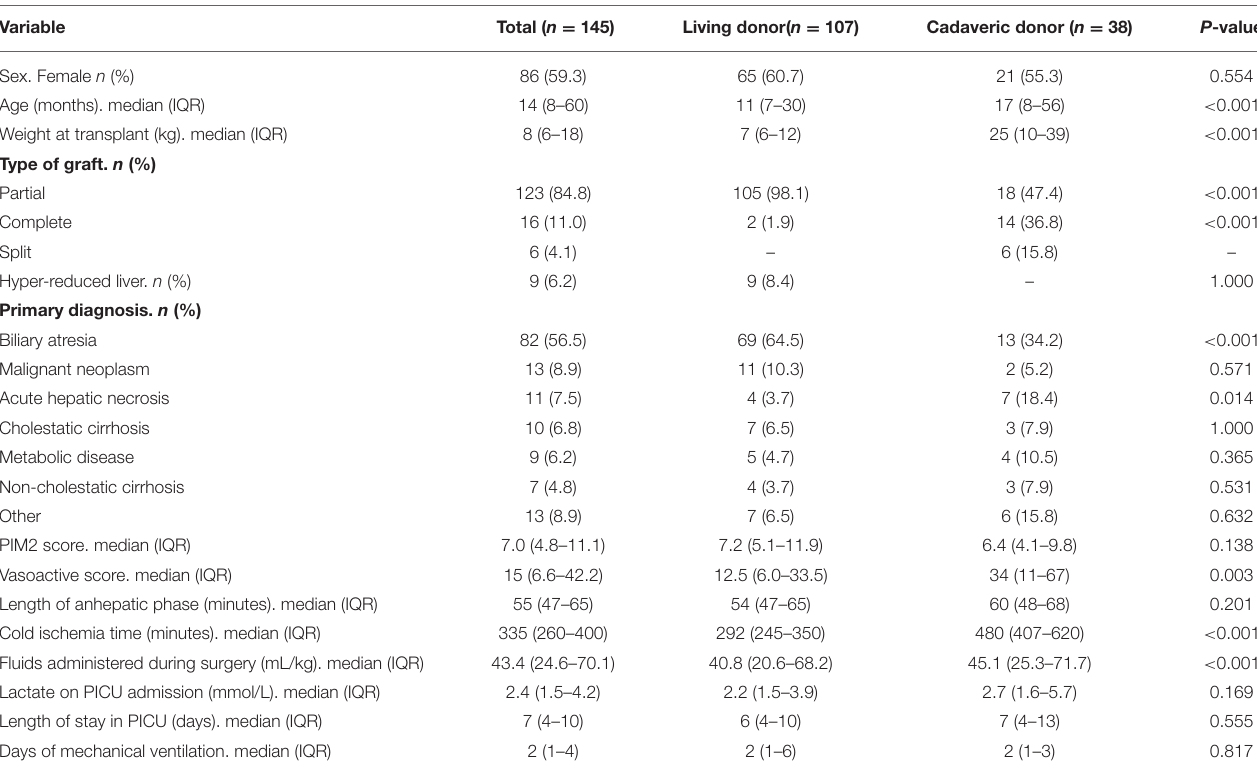
TABLE 1 | Distribution of clinical variables in the study population according to type of donor.